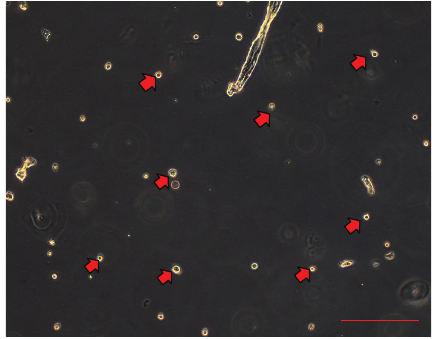
Figure 6: Sarcosphere assay on OSA3. After 24h from the start of the assay, cells appear floating and isolated from each other (cells are indicated by the black/red arrows). Observation in phase contrast. Original magnification: